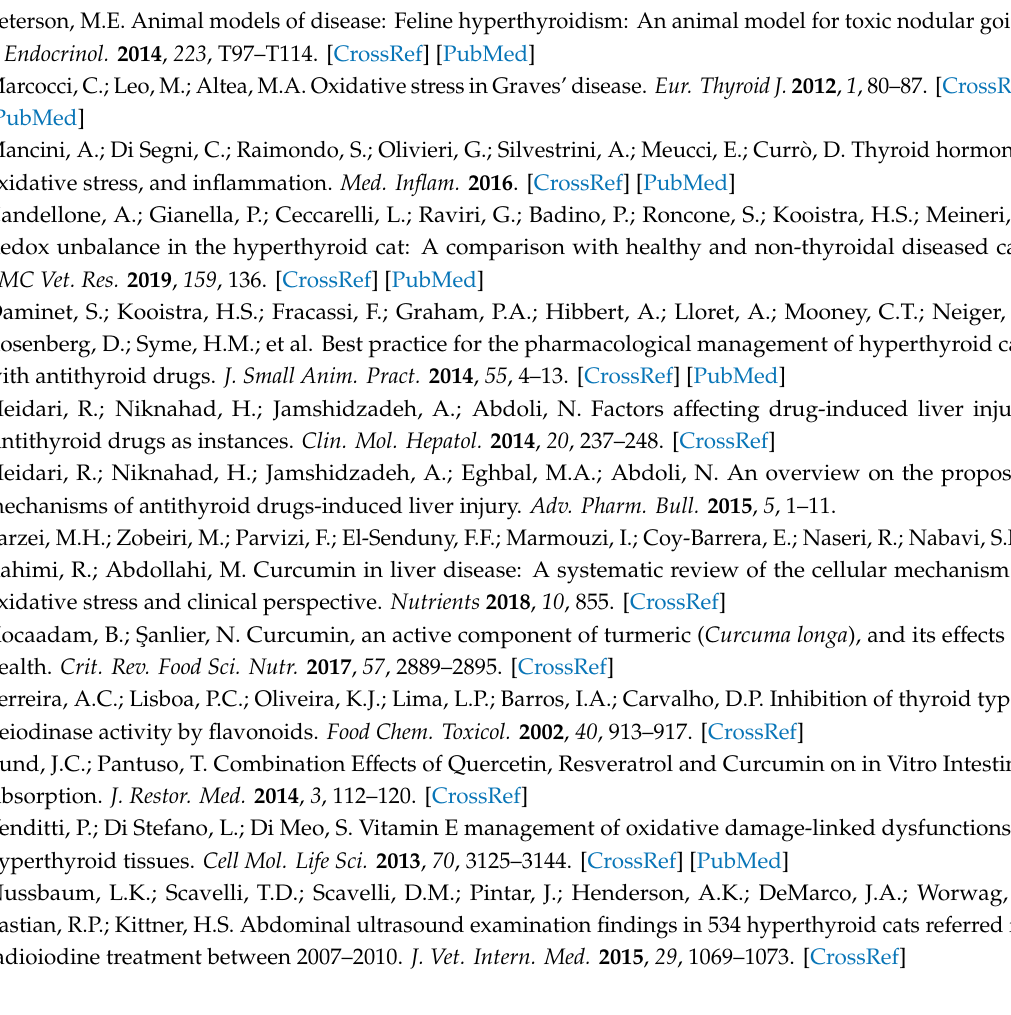
Table S1: Standardized questionnaire formulated ad hoc for the evaluation of clinical signs and symptoms of hyperthyroid cats, as reported by the owner (Owner Hyperthyroid Cat Clinical Score, OHCCS), Table S2: Standardized questionnaire formulated ad hoc for the evaluation of clinical signs and symptoms of hyperthyroid cats, as reported by the veterinarian (Veterinarian Hyperthyroid Cat Clinical Score, VHCCS), Table S3: Standardized questionnaire formulated ad hoc for the evaluation of MMI-related side e ff ects (Side E ff ects of Methimazole Treatment,